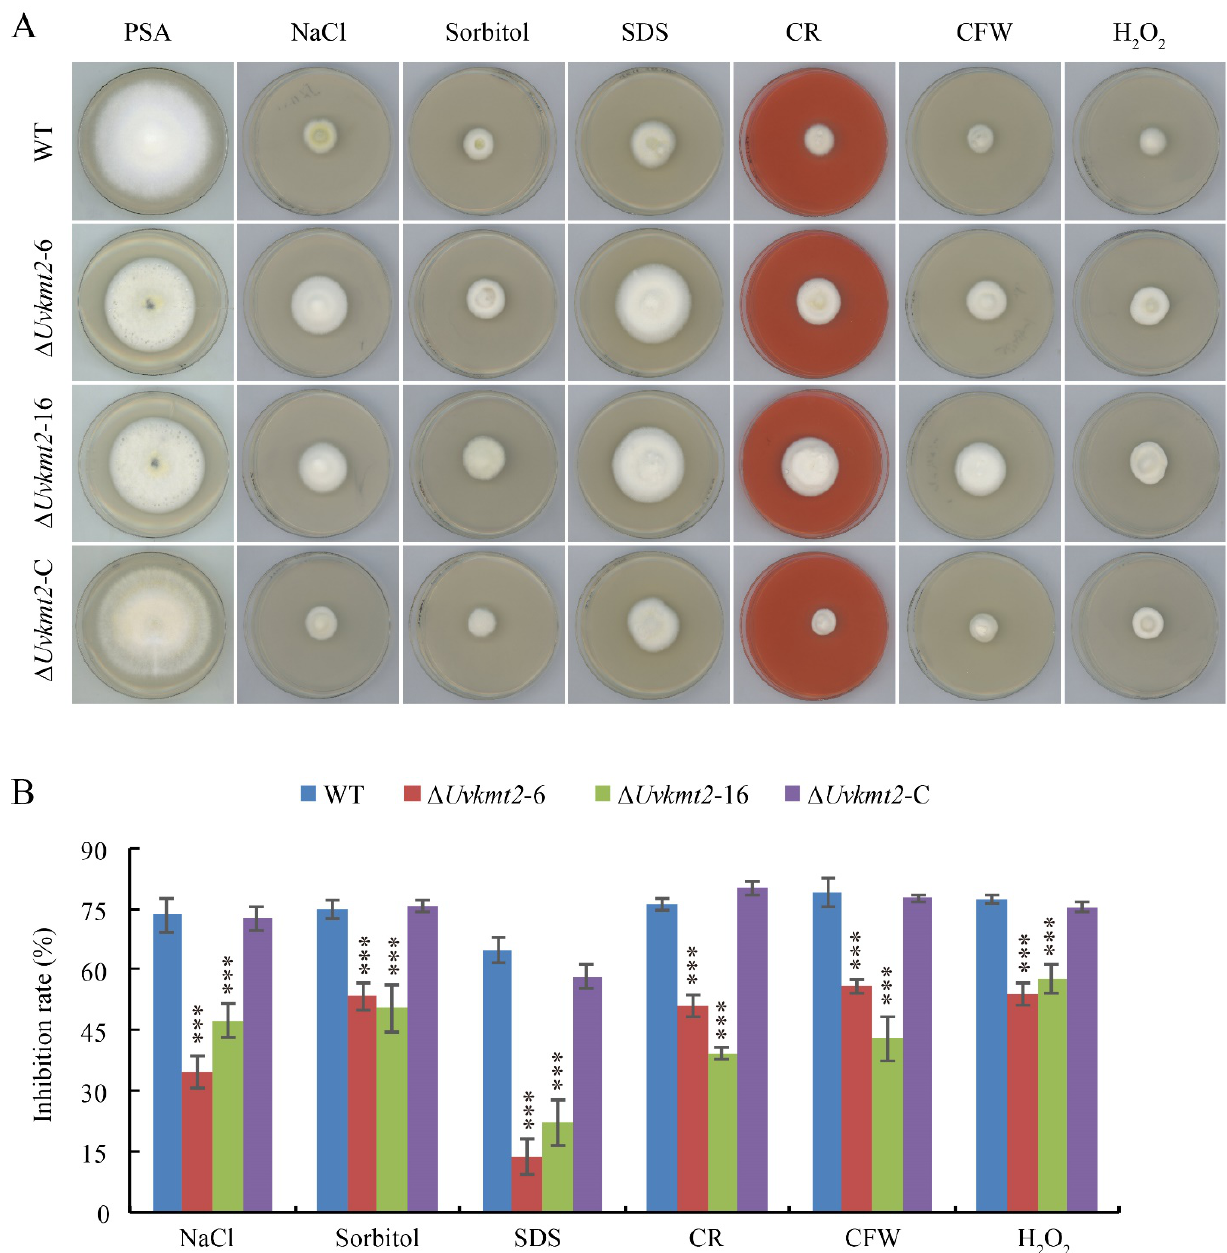
Figure 8. UvKmt2-mediated H3K4me3 modification is involved in various stresses adaption. ( A ) Colony morphology of indicated strain in the presence of different stress-mimicking chemicals. Mycelial plugs were inoculated on PSA plates supplemented with NaCl, sorbitol, SDS, Congo red, CFW, or H 2 O 2 for 14 d. The Δ Uvkmt2 -6 and -16 mutants were more sensitive to osmotic, cell wall, and oxidative stresses. ( B ) Statistic analysis of the relative growth inhibition rate under osmotic, cell wall, and oxidative stress conditions. Error bars represent the standard deviations from three independent replicates. ***, p < 0.001.